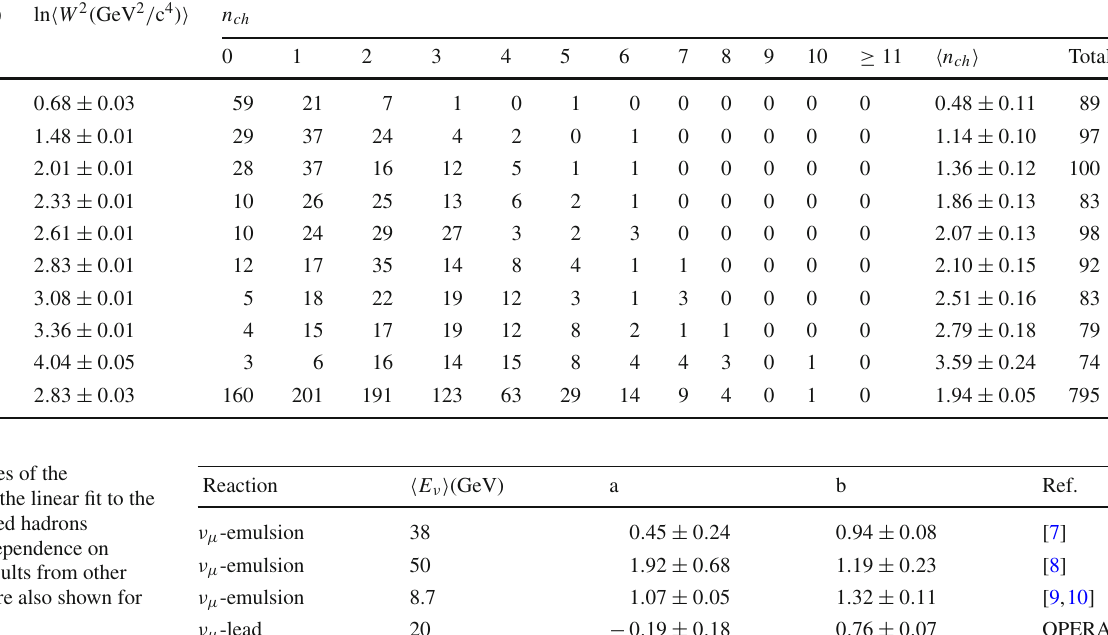
Table 3 The charged hadron multiplicity n ch distribution as a function of W 2 (efficiency corrections are not applied and errors shown are statistical only)